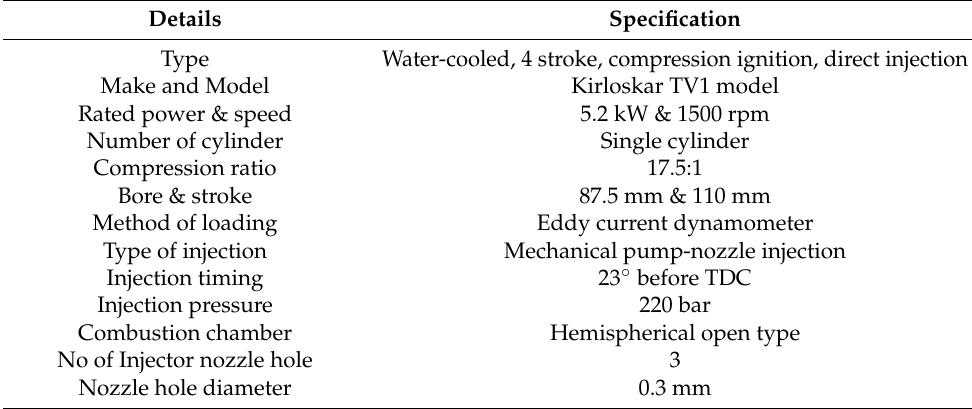
Table 2. Specification of the test engine setup.